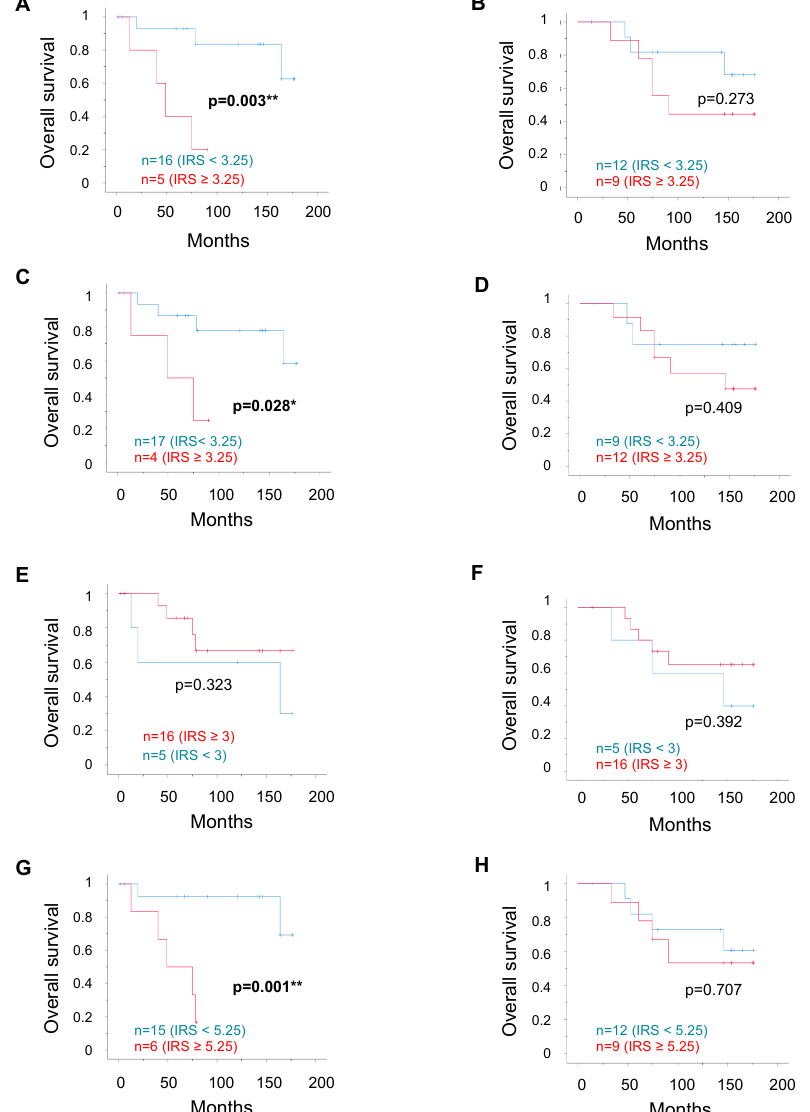
Figure 2. Patient overall survival (OS) according to RIP140, LCoR, ER α , or ER β expression. Kaplan–Meier analysis of the correlation between RIP140 ( A , B ), LCoR ( C , D ), ER α ( E , F ), or ER β ( G , H ) expression with OS in the matched pairs of unifocal ( A , C , E , G ) or multifocal ( B , D , F , H ) breast cancers. The IRS cut-off values together with the number of cases in each arm are indicated in each panel. Correlations are statistically significant for p < 0.05 (*) and for p < 0.01 (**).